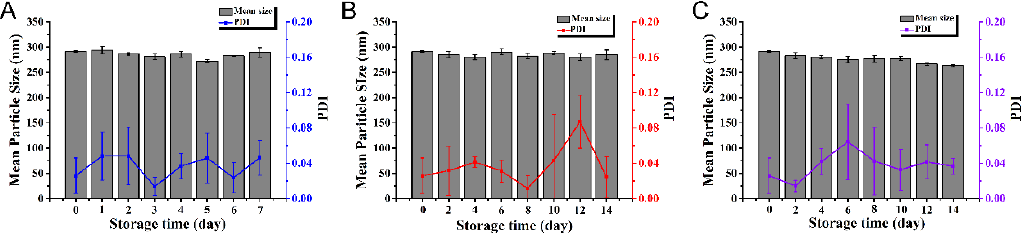
Figure 5. E ff ects of temperature on the MPS and PDI of the nanocapslues. ( A ) 0 ◦ C; ( B ) 25 ◦ C; and Figure 5. Effects of temperature on the MPS and PDI of the nanocapslues. ( A ) 0 °C; ( B ) 25 °C; and ( C ) 54 ◦ ( C ) 54 °C.